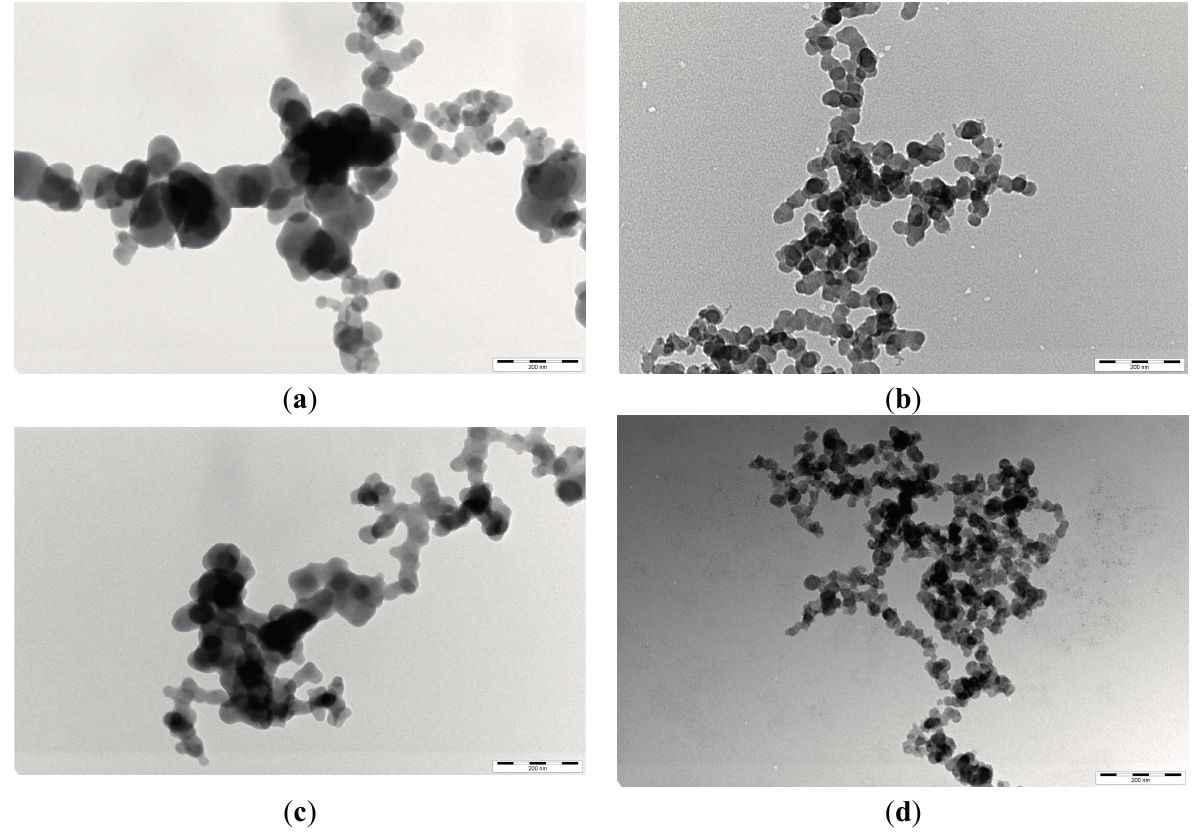
Figure 4. TEM images of nano COM and nano COD crystals in presence of different concentration of HP. ( a , b ) COM; ( c , d ) COD; (a,c) c (HP) = 0.02; (b,d) c (HP) = 0.20 mg/L. Incubation time: 24 h. Scale bars: 200